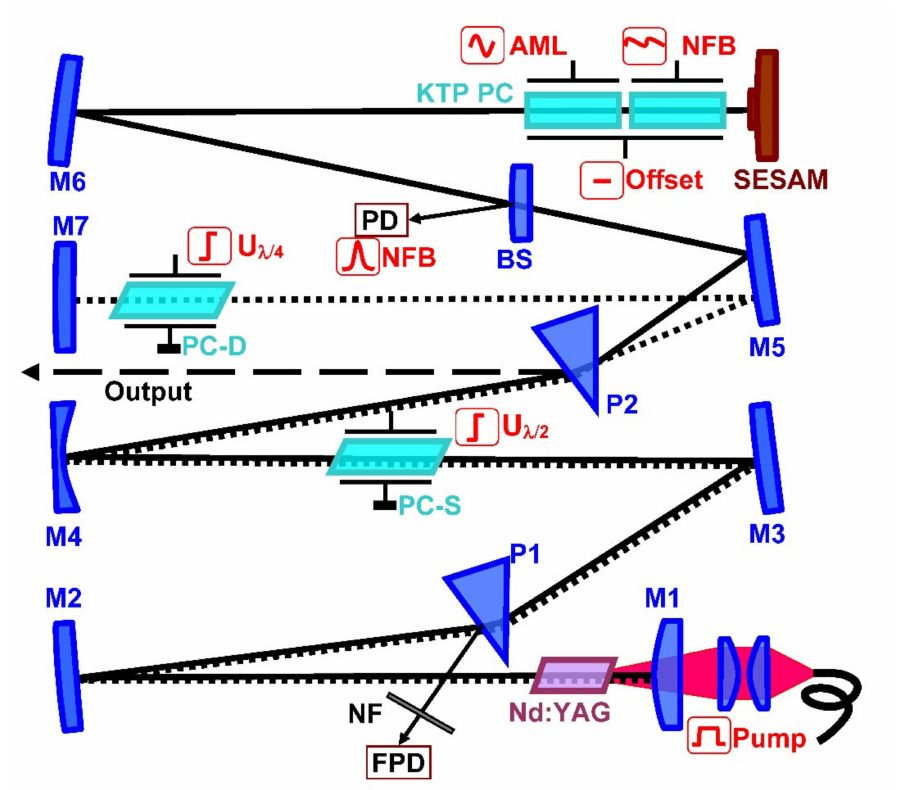
Figure 5. Optical scheme of pulsed-periodic picosecond Nd:YAG laser. The optical path inside the master oscillator is shown by the solid line, the inside regenerative amplifier by the dotted line. The optical path of the beam leaving the picosecond laser is shown by the dashed line. KTP PC is KTP based Pockels cell, PC-S is DKDP Pockels cell of switcher and PC-D is DKDP Pockels cell of